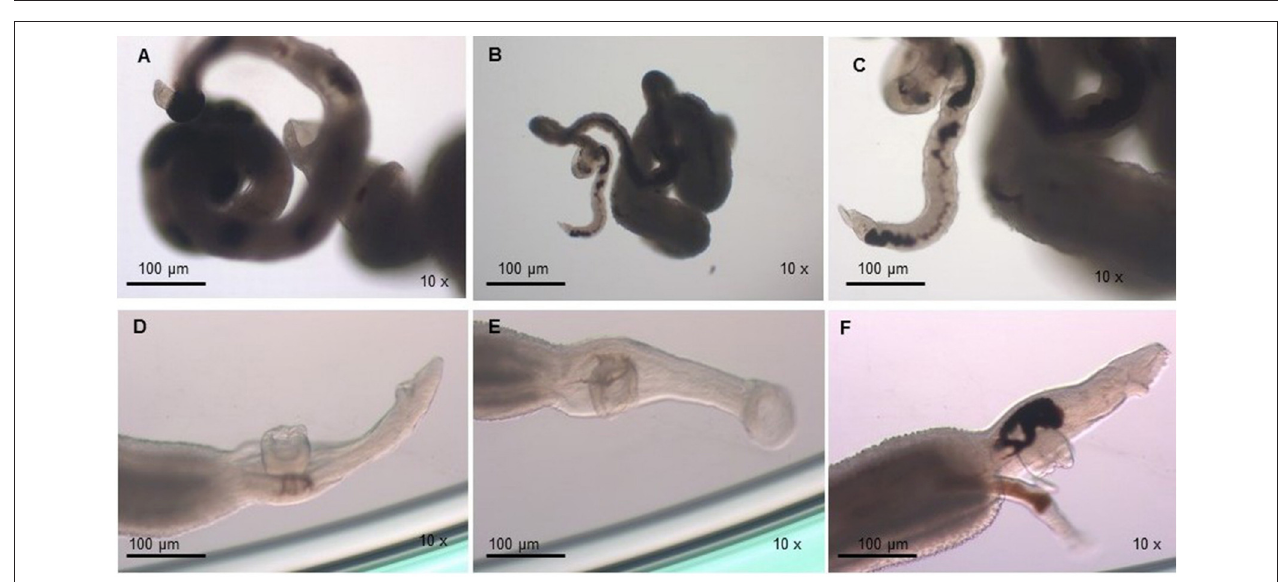
FIGURE 2 | Monitoring of S. mansoni resistant strain adult worms submitted to 32 µ M of PZQ during 48 h. (A) Adult worms from the resistant strain exposed to PZQ, showing muscle contraction, and reduction of movements; (B) Adult worms from the resistant strain exposed to PZQ, showing muscle contraction, and little movements (24 h after drug exposure); (C) Adult worms from the resistant strain exposed to PZQ, began to gain some motility by the end of the incubation period (48 h); (D) Adult worms from the resistant strain not exposed to PZQ (negative control group—resistant worms kept in RPMI-1640 medium with no addition of the drug); (E) Adult worms from the resistant strain not exposed to PZQ (negative control group—resistant worms kept in RPMI-1640 medium with no addition of the drug), 24 h of incubation period; (F) Adult worms from the resistant strain not exposed to PZQ (negative control group—resistant worms kept in RPMI-1640 medium with no addition of the drug), at the end of the incubation period (48